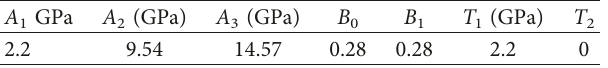
Table 6: Parameters of polynomial state equation of water. A 1 GPa